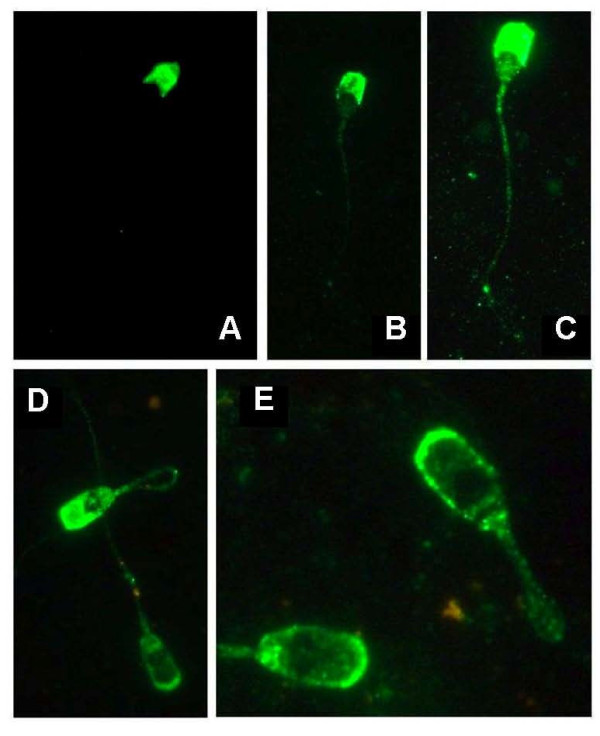
Immunolocalization of fertilin on epididymal spermatozoa. Sperm from caput (A, B and C) and cauda (D and E) epididymis were incubated with the anti-ADAM-1 C-terminal polyclonal antibody and its localization was revealed with a secondary fluorescent conjugated antibody. Sperm were from the same animal and the observations were done at × 630 (A and B) and at × 1000 (C, D and E).